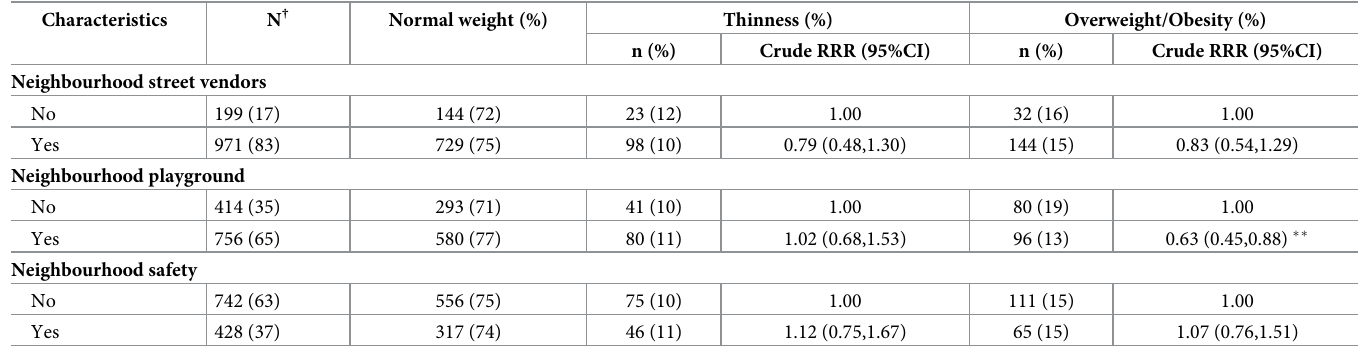
Table 3. Home neighborhood environment correlates for overweight and obesity (N =